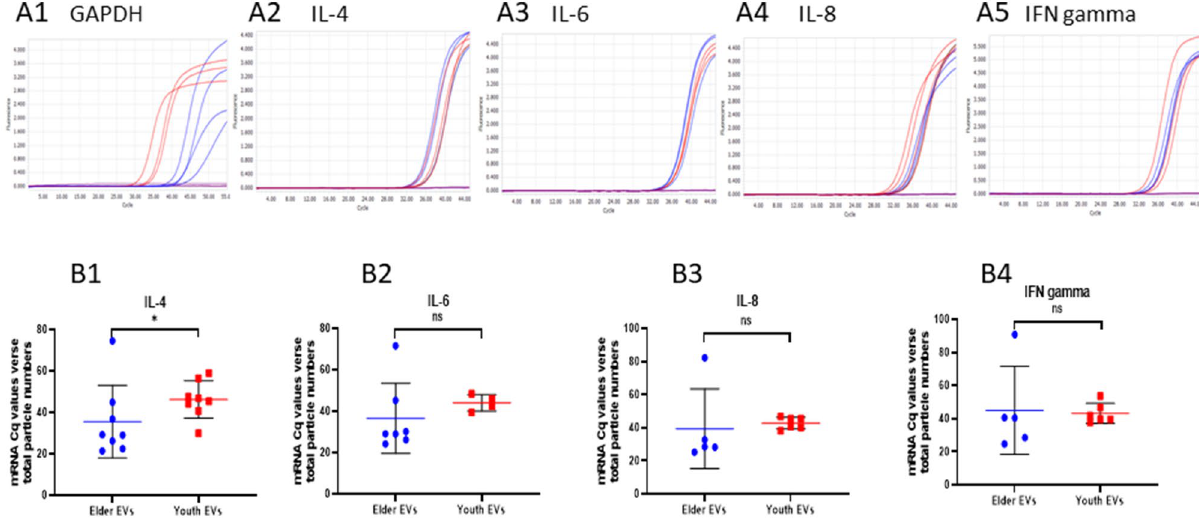
Figure 4. mRNA expression of urine EVs derived from young and old adults. ( A ) qRT-PCR amplification curves of GAPDH and cytokines. The housekeeping gene, GAPDH ( A1 ), mRNA expression levels revealed a wide variation among EVs derived from 8 young adults (red lines) and 8 old adults (blue lines) in comparison to those of IL-4 ( A2 ), IL-6 ( A3 ), IL-8 ( A4 ) and IFNγ ( A5 ). ( B ) Analyses of cytokines mRNA expression profiles. Results as normalized by individual number of EVs showed a significant lower level of IL-4 ( B1 ), but not IL-6 ( B2 ), IL-8 ( B3 ), or IFN-γ ( B4 ), expression in the EVs from the elderly than the EVs from young adults. *Indicates p < 0.05 and “ns” indicates no significant difference, analyzed by the Mann–Whitney U test.